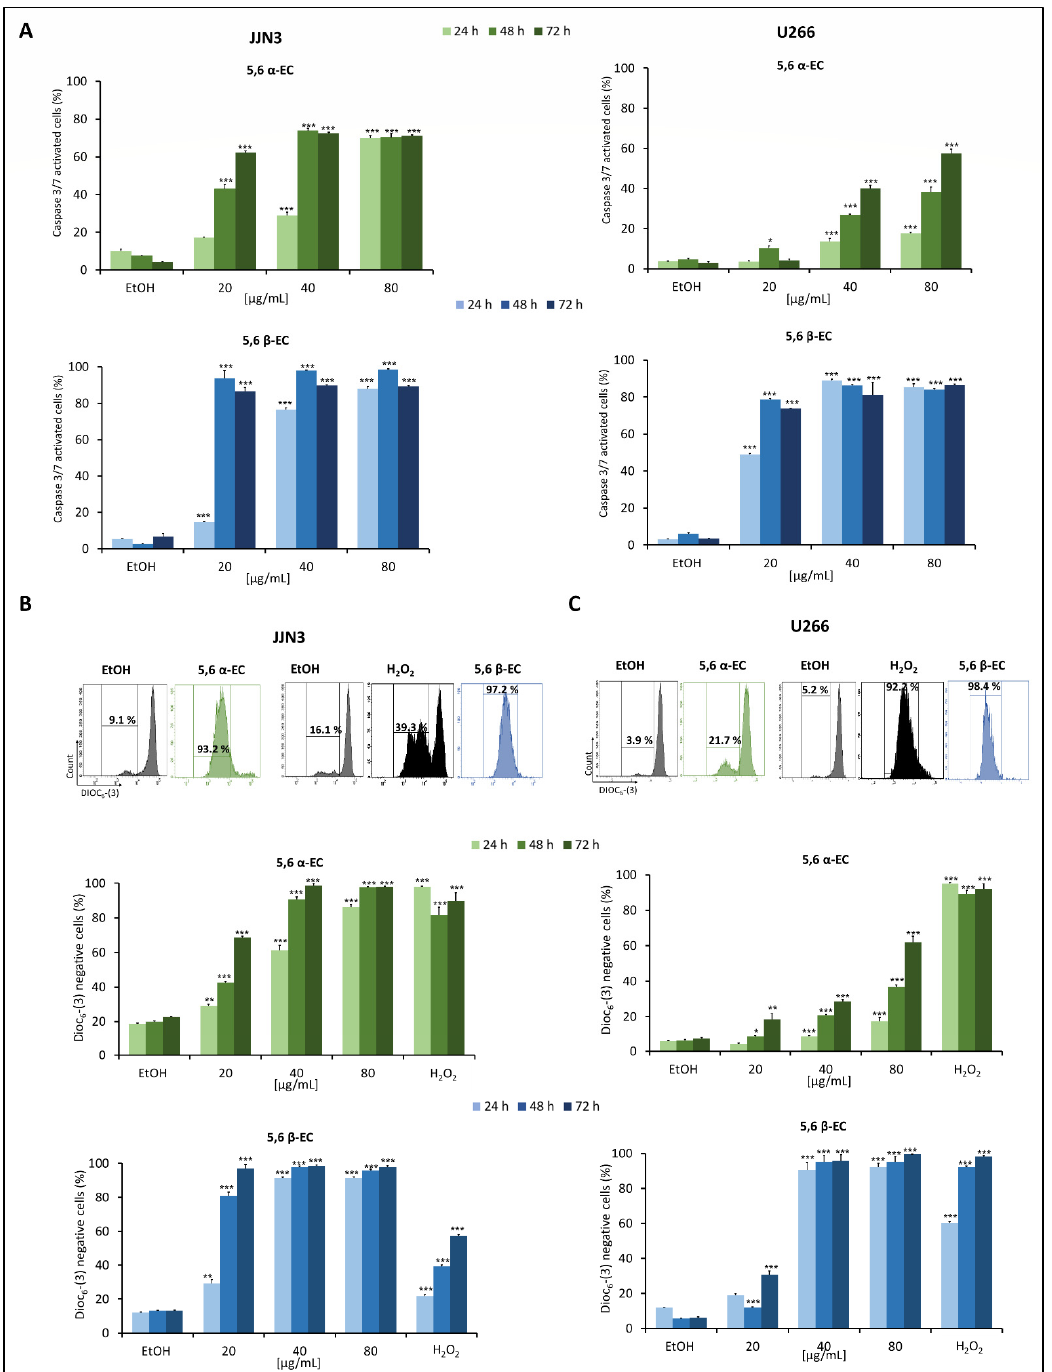
Figure 3. The apoptotic intrinsic pathway is triggered by 5,6-ECs treatment in HMCLs. ( A ) JJN3 and U266 cells were seeded in 24-well plates at a density of 2 × 10 5 cells/well for 24 h and treated with 5,6 α -EC or 5,6 β -EC (20–80 µ g/mL) for 24–72 h. Caspase 3/7 enzymatic activity was detected by flow cytometry in both cell lines. The percentage of cells with activated caspase 3/7 was presented in histograms as the mean ± SD (Table S6). The percentages of DiOC 6 -(3) negative (with depolarized mitochondria) JJN3 ( B ) or U266 ( C ) cells obtained by flow cytometry are showed in histograms as the means ± SD. H 2 O 2 (500 µ M) was used as a positive control. No statistically significant difference between control and vehicle (EtOH) was noticed. * p < 0.05; ** p < 0.01; *** p < 0.001 with the t -test (Table